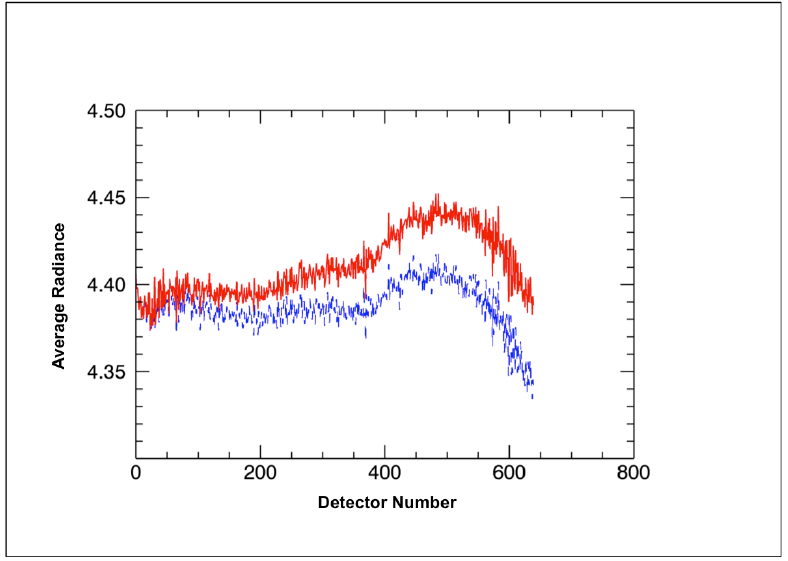
Figure 5. Column averages obtained from the horizontally corrected data of Figure 4. The red solid curve shows the column averages obtained from the nominal horizontal correction (Figure 4(center)) while the blue dashed curve shows the column averages obtained from the enhanced correction (Figure